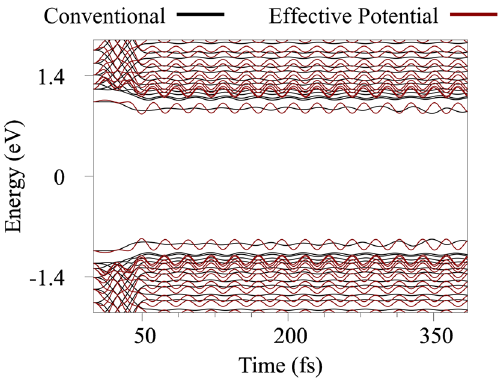
Figure 3. Time dependence of the electronic structure around the band gap. The red and black lines represent electronic states for π -electrons through the effective field and standard approaches, respectively. The states associated with the polaron are visible above the valence band and below the conduction